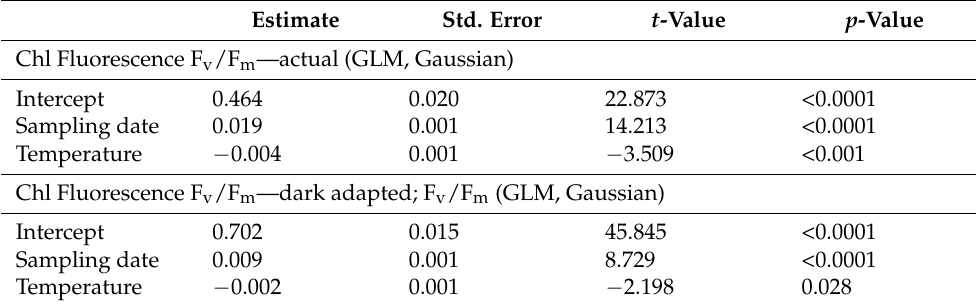
Table 3. Estimated regression parameters, standard errors, t -values, and p -values for the actual chlorophyll fluorescence and after-dark adaptation of Pistia stratiotes